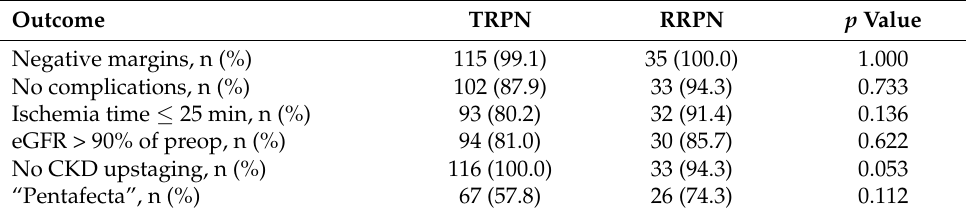
Table 4. Pentafecta analysis comparing TRPN and RRPN.